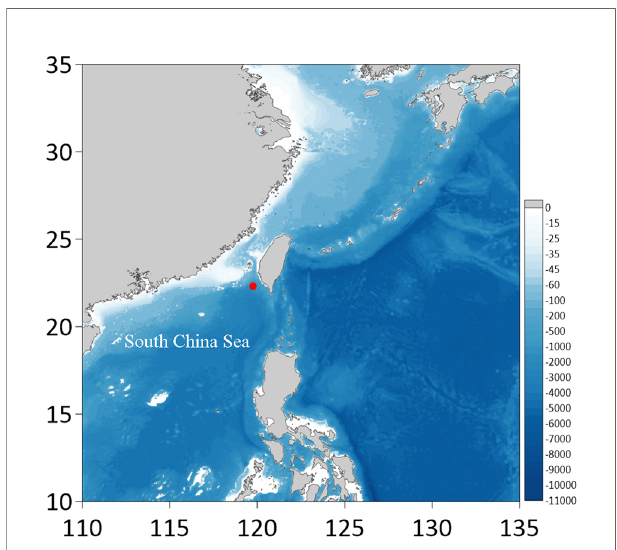
FIGURE 1 | A map showing the location of sampling site (red circle) in the South China